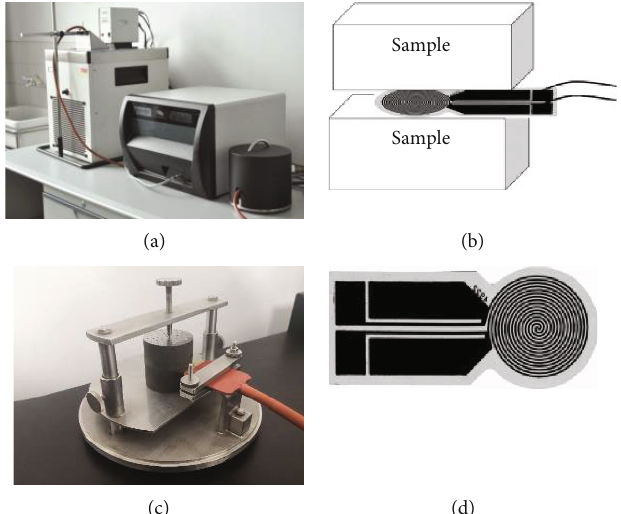
Figure 1: Thermal constant analyzer and test principle: (a) Hot Disk Thermal Constant Analyzer (TPS2500s); (b) The heat source probe forms a sandwich structure with the sample; (c) Sample testing; (d) Plane heat source probe.